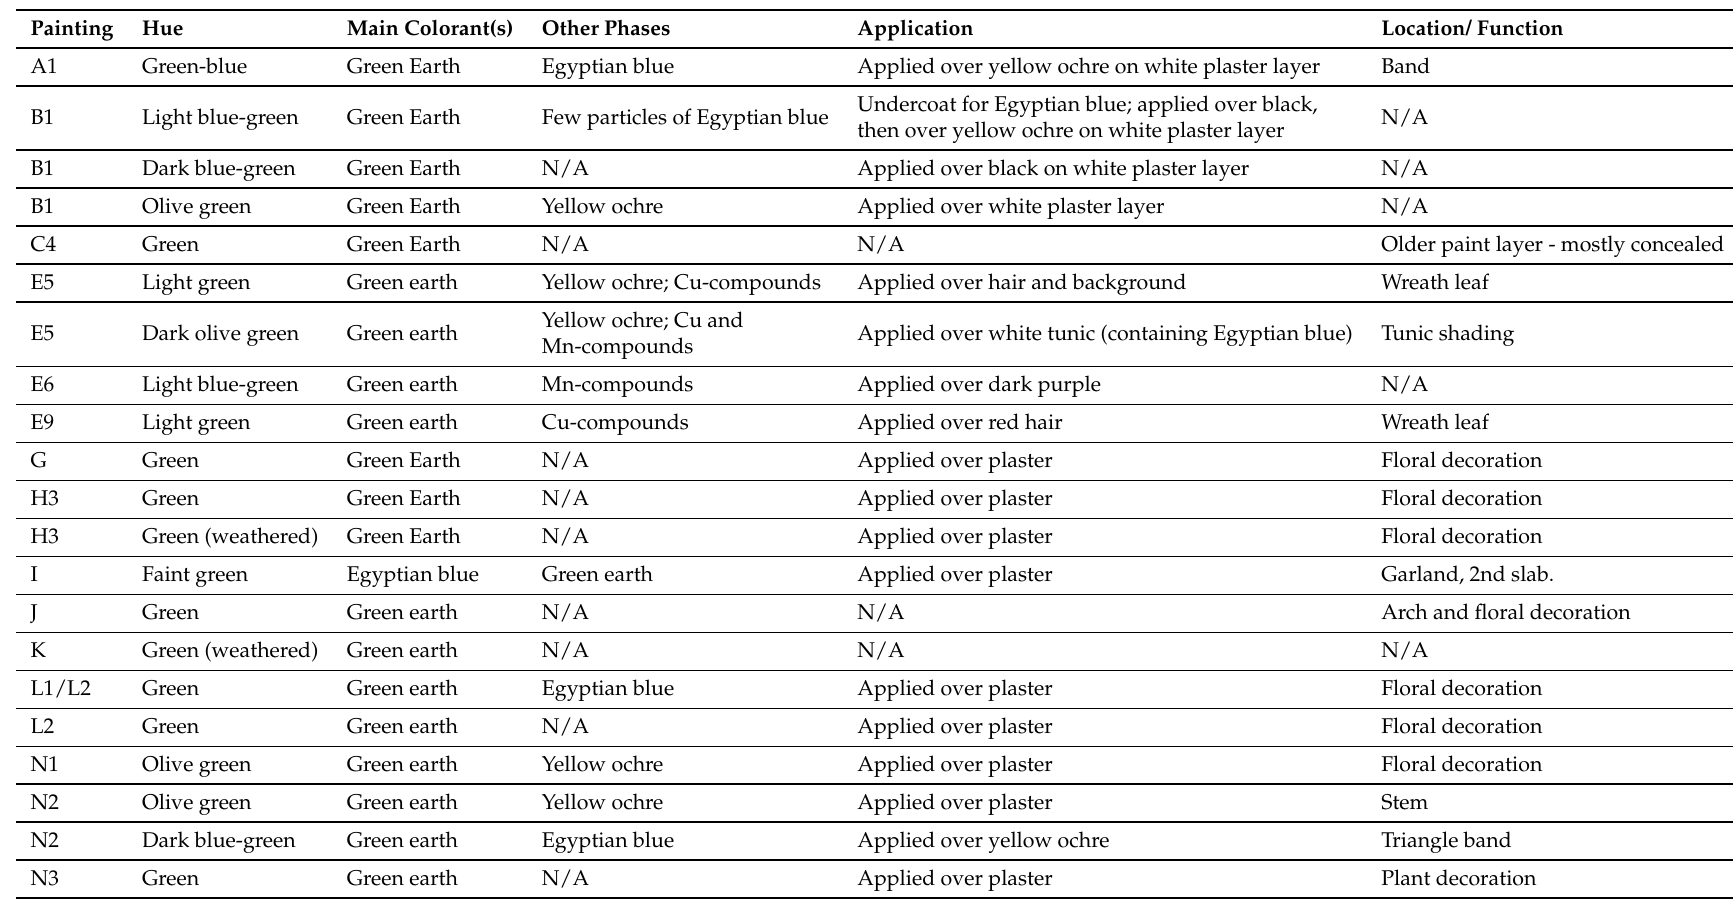
Table A2. Detailed list of the identification and application methodology of green earth in the Cypriot wall